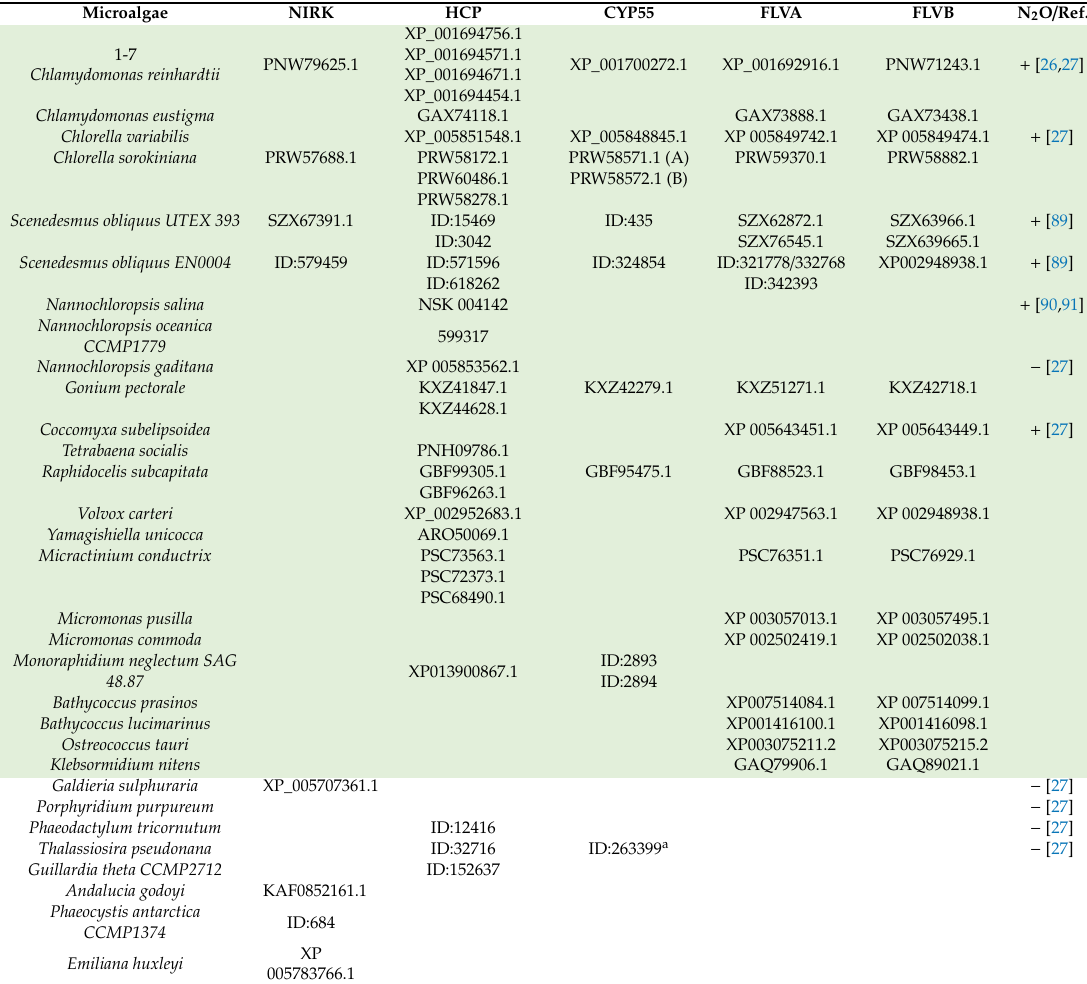
Table 2. Microalgal production of N2O and putative NIRK proteins, involved in NO formation, and putative HCP, CYP55, and FLV, involved in NO reduction to N 2